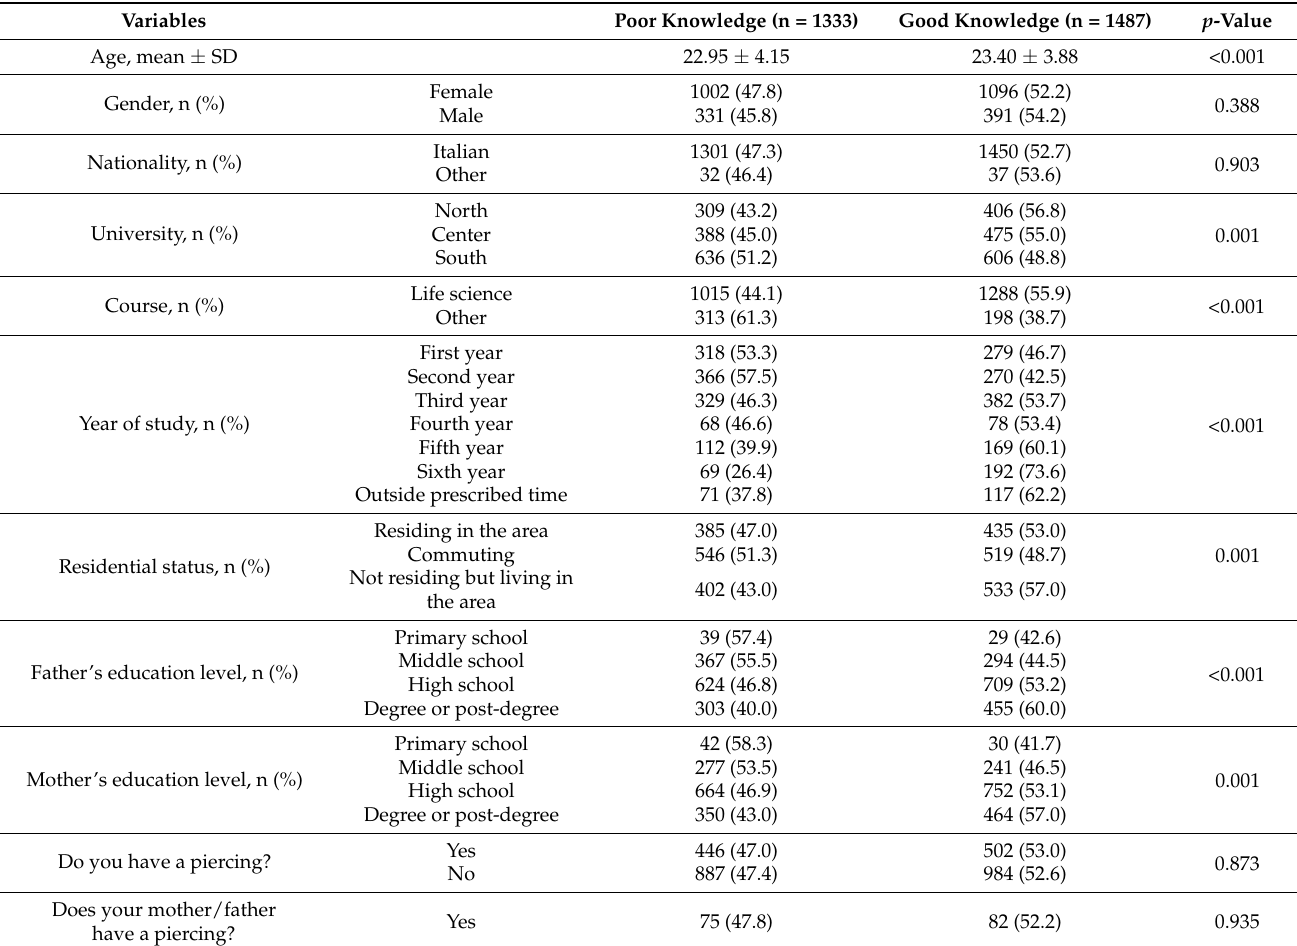
Table 3. Univariate analysis of knowledge about piercing health risks.